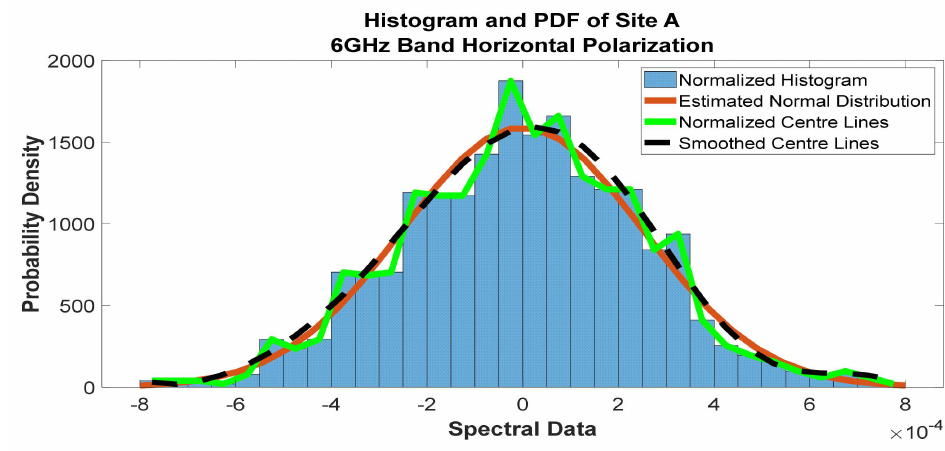
Figure 11. Histogram and PDF of the frequency scan for site A at 6 GHz horizontal polarization.